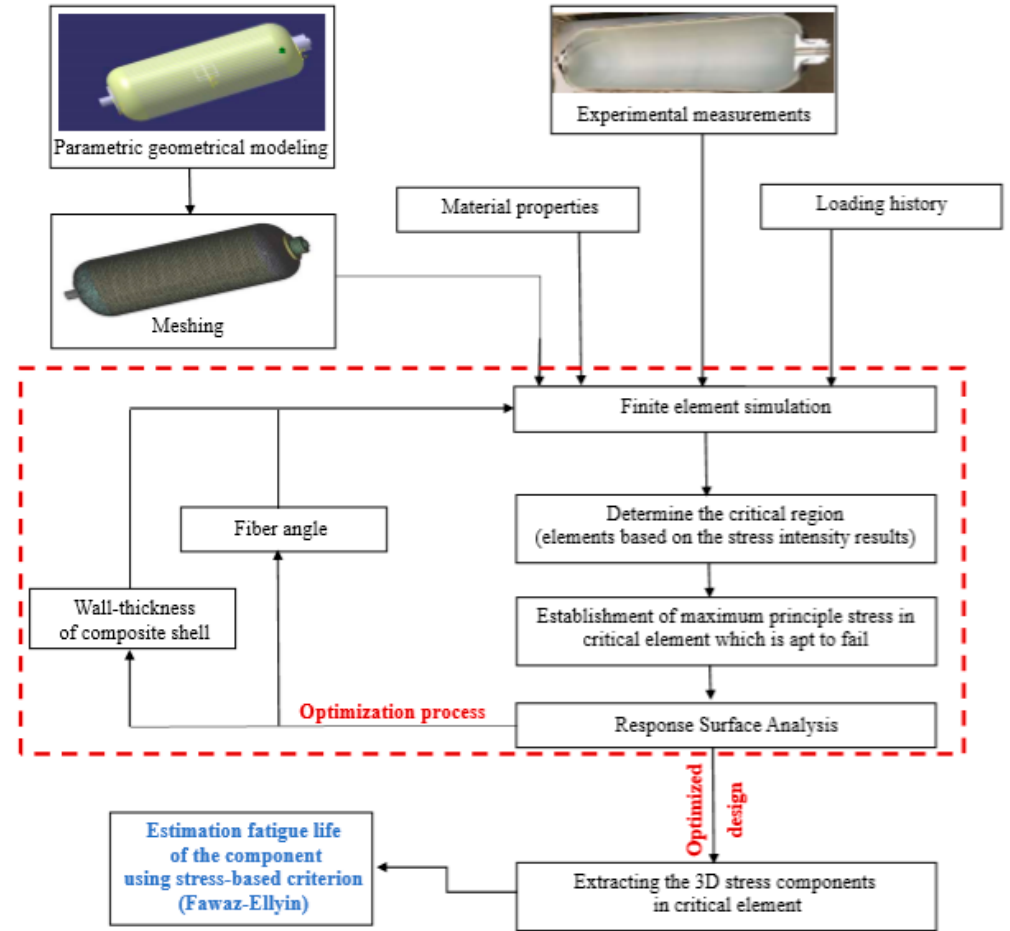
Figure 1. The proposed algorithm for fatigue life improvement of a composite type-4 compressed natural gas (CNG) tank.